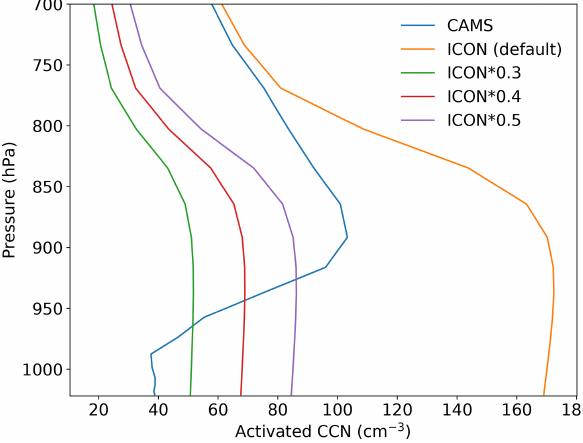
Figure A1. Profile of activated CCN at 0.08ms − 1 from CAMS and from the default profile in ICON. Additionally, a subset of scaled ICON profiles is